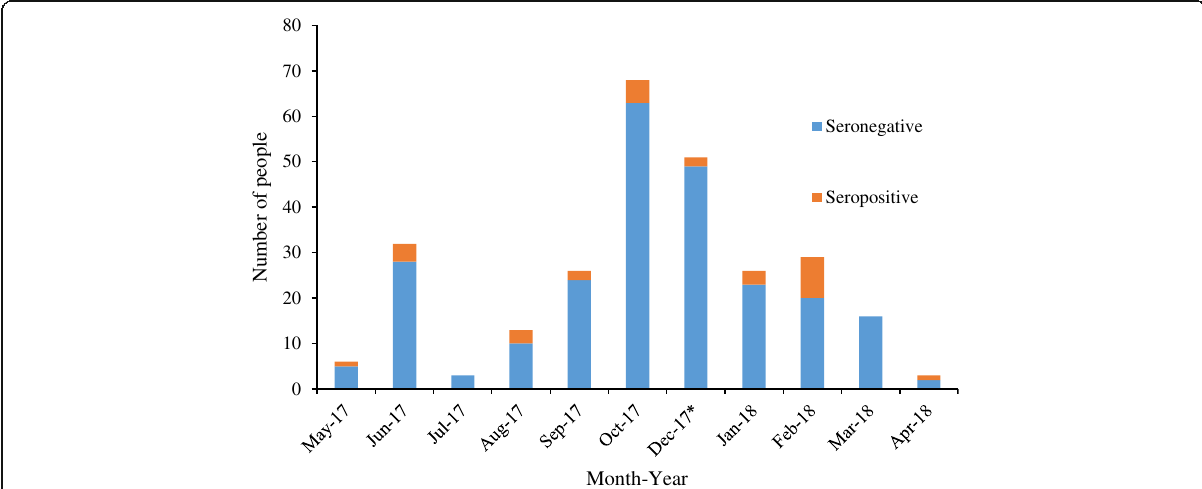
Fig. 3 a. EBOV Western blot. Lane 1=Rabbit anti-EBOV GP polyclonal serum, Lane 2=EBOV positive patient serum, Lane 3=Negative patient serum,